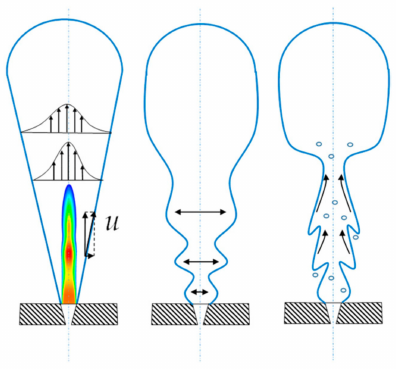
Figure 18. Entrainment driven by velocity